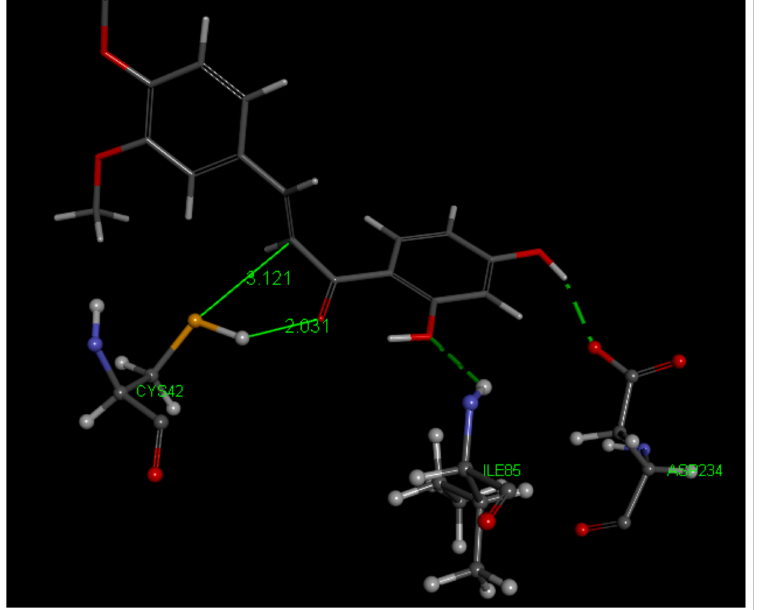
Figure 21. Pose 2 after docking DHDM ( 2 ) in the 3BPF receptor. The closest interaction for S(Cys42) to the chalcone involves the ethenyl α carbon, 3.121 Å. H bonds with Ile85 and Asp234 are also